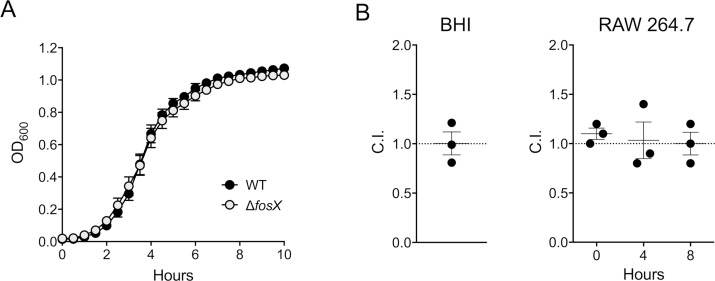
fosX is fitness neutral.(A) Growth curves of L. monocytogenes P14 (WT) and isogenic ΔfosX mutant in BHI. Mean ± SEM of five duplicate experiments. (B) Competition experiments between P14 and ΔfosX in BHI (left panel) and RAW 264.7 mouse macrophages (right panel). BHI broth or RAW 264.7 cell monolayers were inoculated with a 1:1 mix of both bacteria and the competition indexes (C.I.) determined after incubation of 18 h at 37 °C or at the indicated intracellular infection time points. t = 0 corresponds to 1 h after infection (30 min incubation after addition of inoculum and centrifugation plus 30 min gentamicin treatment). Mean ± SEM of three duplicate experiments, a C.I. = 1 indicates equal competing ability. One-sample Student´s t test (hypothetical value 1, two tails) P values: BHI = 0.977; macrophages = 0.2254, 0.874 and ≥0.999 for t = 0, 4 and 8 h, respectively. Similar results as in BHI were obtained using less rich media (Luria-Bertani broth, C.I. = 0.92± 0.05, P = 0.331; chemically-defined IMM medium, C.I. = 1.037±0.071, P = 0.657).